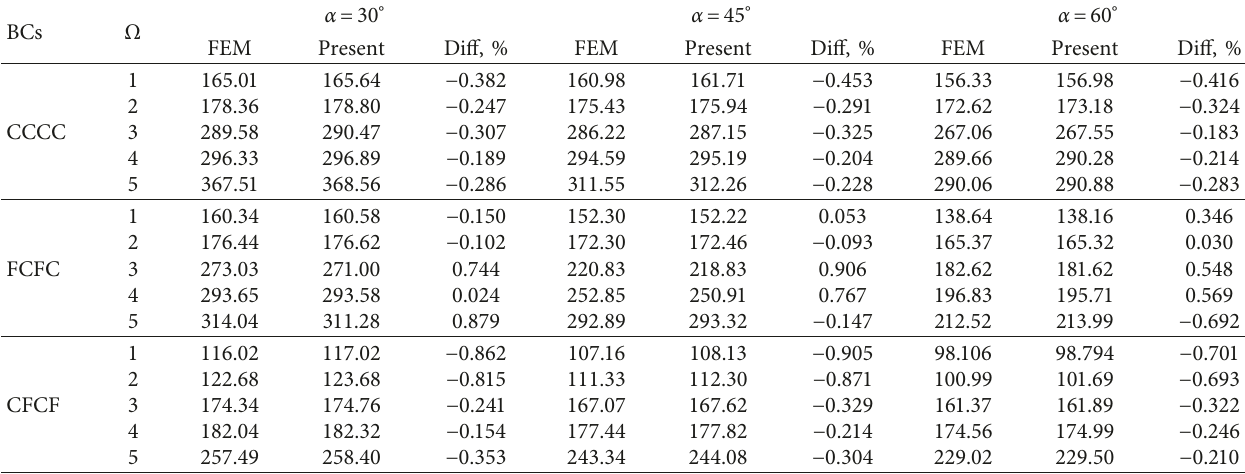
� 0/ b �− 0.5/ c � 2/ p � 2) opens conical shell with two axial I ( a